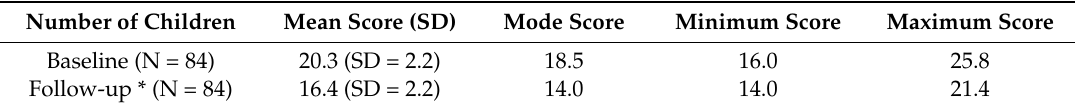
Table 1. Children’s Experiences of Dental Anxiety Measure (CEDAM) interval scores at baseline and following children’s use of the guided self-help cognitive behavioural therapy (CBT) resource and dental